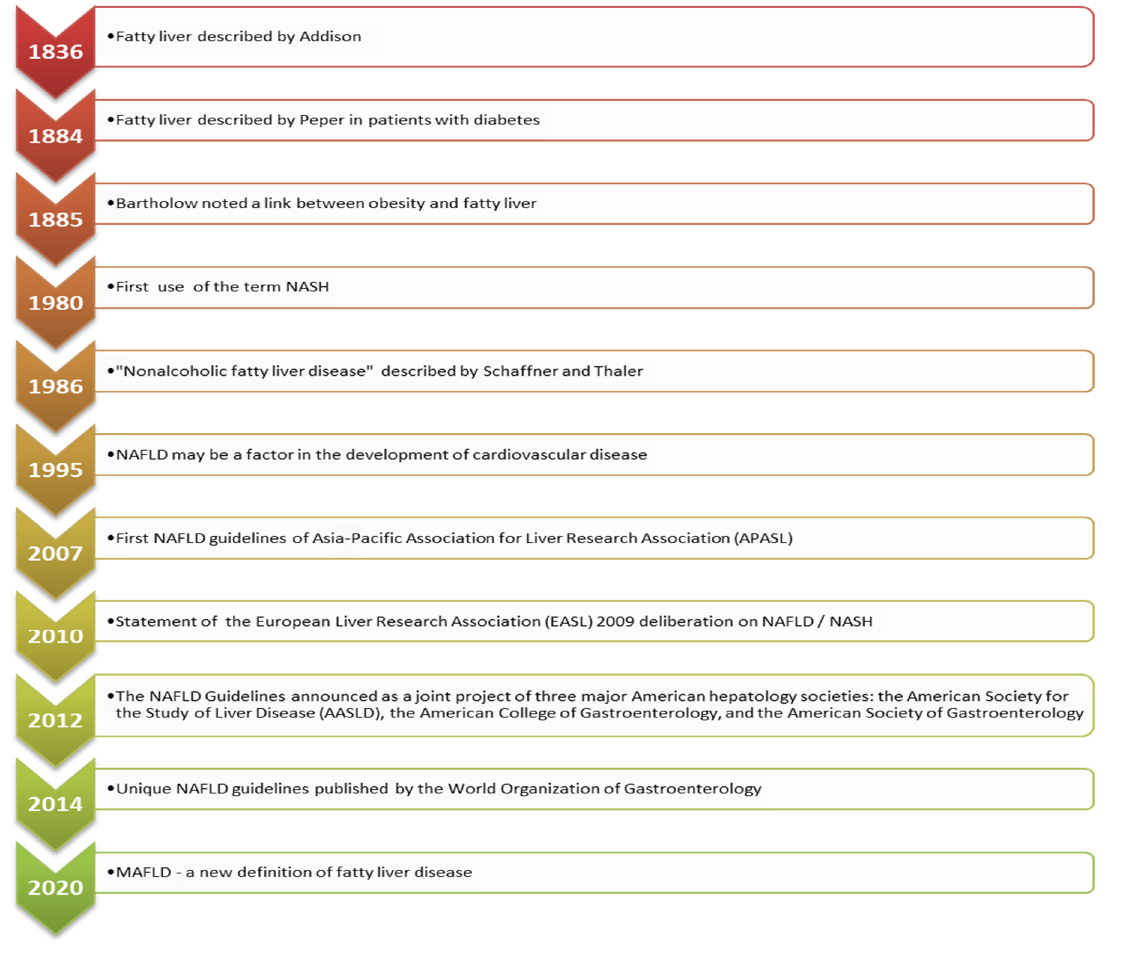
Figure 1. Fatty liver disease timeline [1–8].